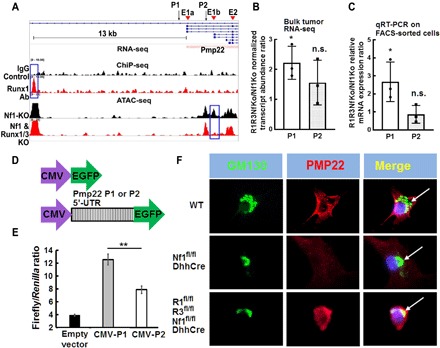
Runx1/3 regulates the alternative promoter usage and affects posttranslational modification of Pmp22.(A) Upper two bands: RUNX1 ChIP-seq showed the binding peak near Pmp22 (blue box). IgG was used as control. Lower two bands: ATAC-seq on Nf1fl/fl;DhhCre and Runx1fl/fl;Runx3fl/fl;Nf1fl/fl;DhhCre showed more Pmp22 P2 open chromatin in Nf1fl/fl;DhhCre SCs (blue box). Top-right corner arrow pointed to TSS. Underneath, red bars indicated that Pmp22 mRNA expression was up-regulated in Runx1fl/fl;Runx3fl/fl;Nf1fl/fl;DhhCre versus Nf1fl/fl;DhhCre mice. Ab, antibody. (B) Ratio of normalized Pmp22 P1 (white bar) and P2 (light gray bar) transcript abundance in Runx1fl/fl;Runx3fl/fl;Nf1fl/fl;DhhCre (R1R3Nf1Ko) versus Nf1fl/fl;DhhCre (Nf1Ko) from bulk tumor RNA-seq data. (C) qRT-PCR showed Pmp22 P1 (white bar) and P2 (light gray bar) relative mRNA expression in Runx1fl/fl;Runx3fl/fl;Nf1fl/fl;DhhCre (R1R3Nf1Ko) over Nf1fl/fl;DhhCre (Nf1Ko) from FACS-sorted EGFP+ cells. n.s., not significant. (D) Diagram showed the cloning strategy of Pmp22 P1 5′-UTR or P2 5′-UTR with CMV into pGL2 luciferase reporter assay vector. Only CMV was used as control. (E) Luciferase reporter assay showed that P2 5′-UTR (CMV-P2) had less posttranscriptional modification activity compared with P1 5′-UTR (CMV-P1) in immortalized WT mouse SCs. (F) Representative immunofluorescence images of GM130 (green) and PMP22 (red) in WT (top), Nf1fl/fl;DhhCre (middle), and Runx1fl/fl;Runx3fl/fl;Nf1fl/fl;DhhCre (bottom) mouse neurofibroma/DRG SCs. White arrows pointed to GM130 (Golgi body) and PMP22 colocalization. *P < 0.05 and **P < 0.01.